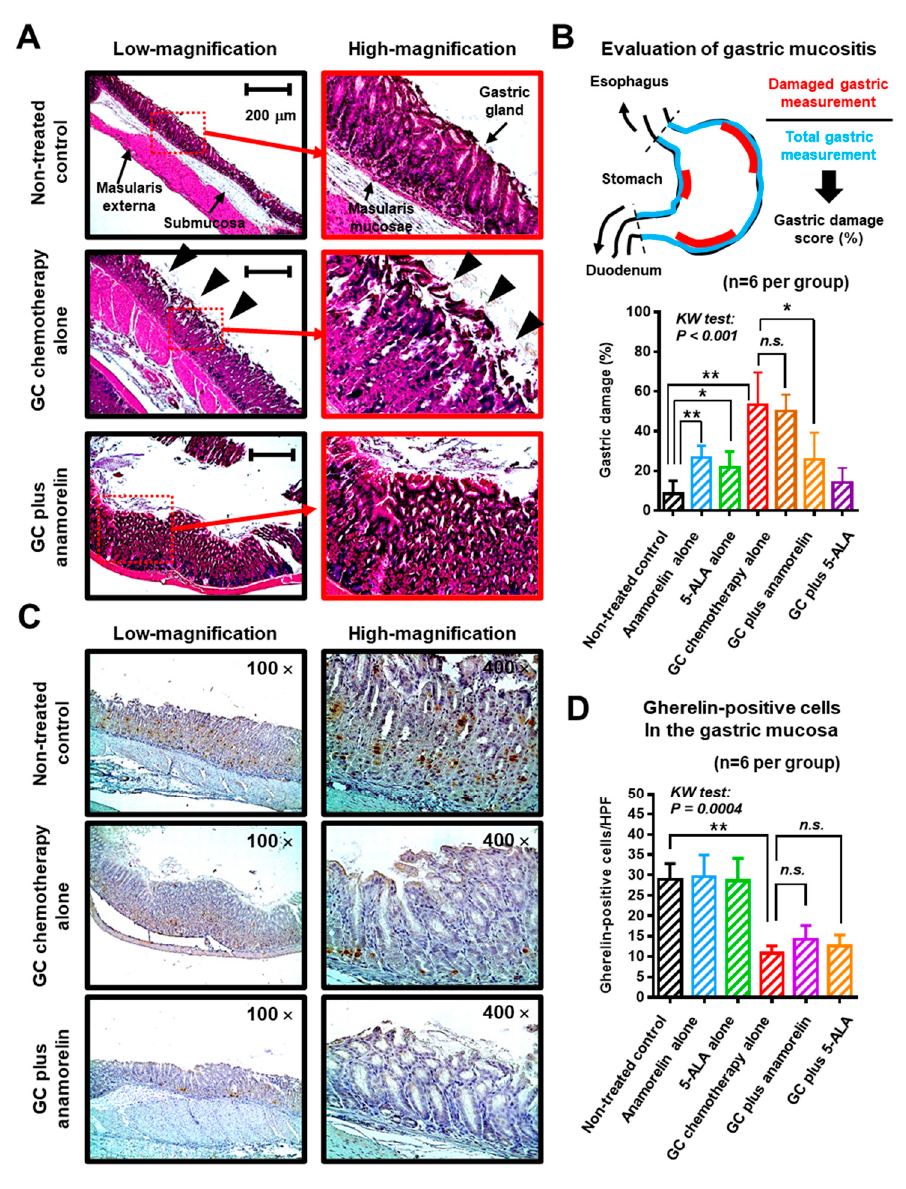
Figure 4. Morphological change and ghrelin expression in gastric mucosa of treated mice. ( A ) Representative morphological images of the gastric wall of non-treated control, gemcitabine / cisplatin (GC) alone, and GC plus anamorelin groups are shown and compared. The panels on the right are magnified images showing the gastric mucosa. GC chemotherapy resulted in substantial changes in the gastric mucosa. The glandular structure was destroyed, resulting in edematous and hemorrhagic mucosa and denuding of the surface layer (black triangles). Thickening of gastric mucosa was found in the GC plus anamorelin group. Original magnification: 200 × . ( B ) Mucositis severity was evaluated by the gastric damage score (%), which was determined using the following formula—damaged gastric measurements divided by total measurements in treated mice. ( C ) Immunohistochemical staining for ghrelin expression in the gastric mucosa of mice. Representative images show the distribution of ghrelin-positive cells (brown staining) in the gastric mucosa of mice treated with GC or GC plus anamorelin. ( D ) The number of ghrelin-positive cells / 5 high power field (HPF) were counted from specimens of 6 mice and averaged. Values represent the mean ± standard deviation. The di ff erences were examined using the Kruskal–Wallis (KW) test, followed by the Dunn post-hoc test. * p < 0.05, ** p < 0.01, n.s. , not significant.